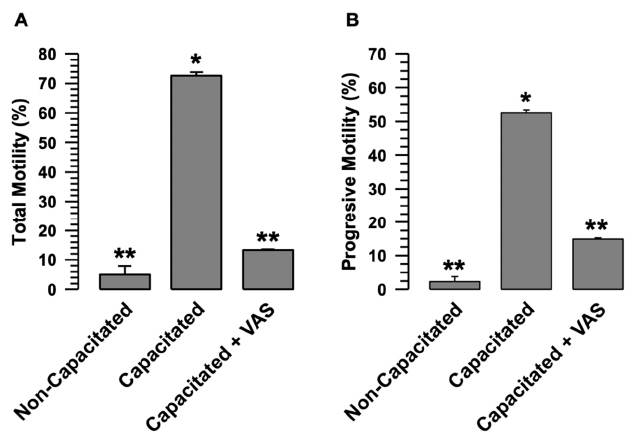
Figure 4. The activity of sperm NOXs is relevant to sperm motility. The role of NOXs in motility was determined; guinea pig spermatozoa were incubated under capacitive conditions in the absence and presence of VAS (VAS2870 40 µM). Sperm motility was assessed by CASA. ( A ) Total motility. ( B ) Progressive motility. Results are expressed as the mean ± S.E. ( n = 3). Differences were